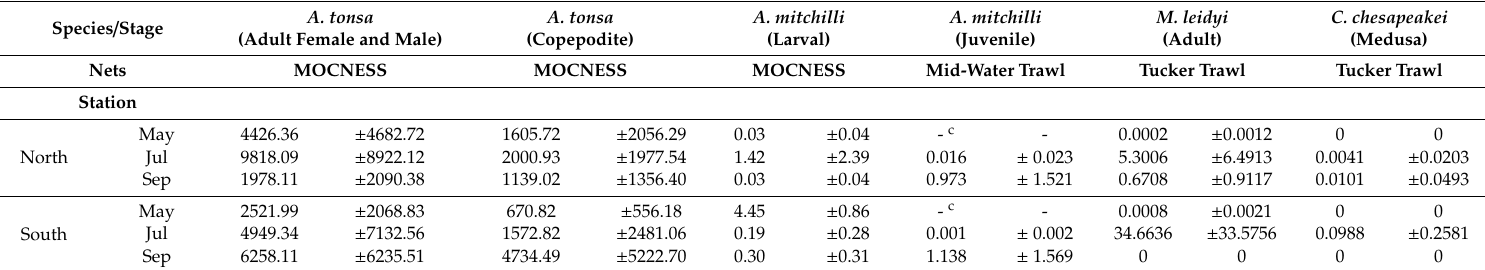
Table A4. Mean concentrations ( ± S.D.) (ind. m − 3 ) of copepods ( Acartia tonsa ), bay anchovies ( Anchoa mitchilli ), ctenophore ( Mnemiopsis leidyi ), and bay nettles ( Chrysaora chesapeakei ) collected from the North and South Stations during the 2011 cruises. Species / Stage